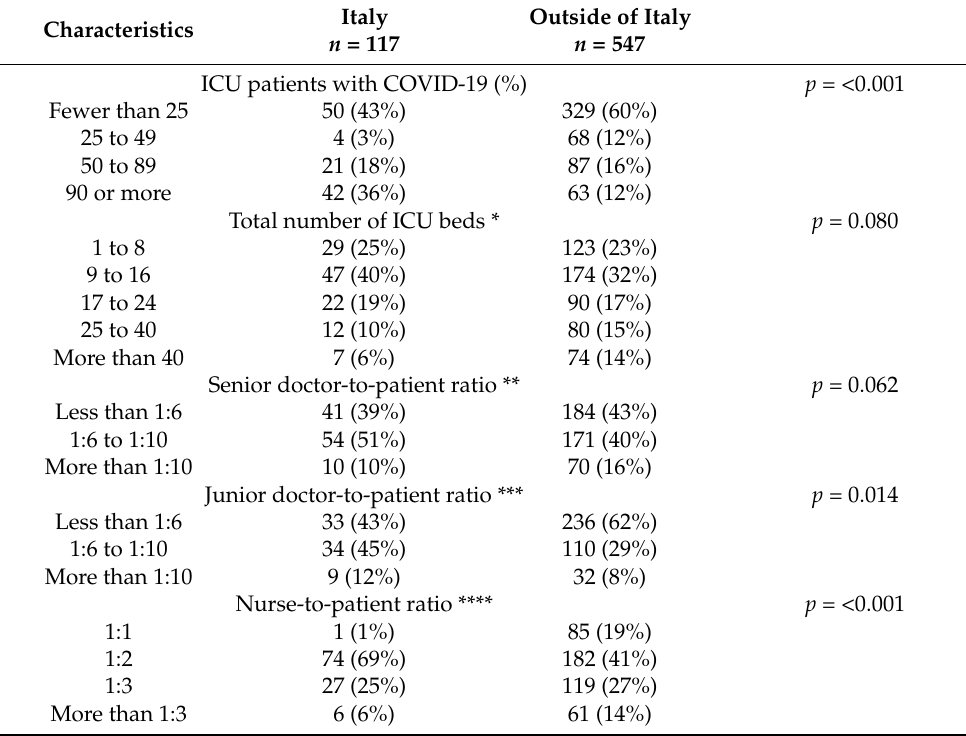
Table 1. Characteristics of ICUs of respondents in Italy and outside of Italy at the time of the survey. Italy Outside of Italy Characteristics n = 117 n = 547 ICU patients with COVID-19 (%) p = <0.001 50